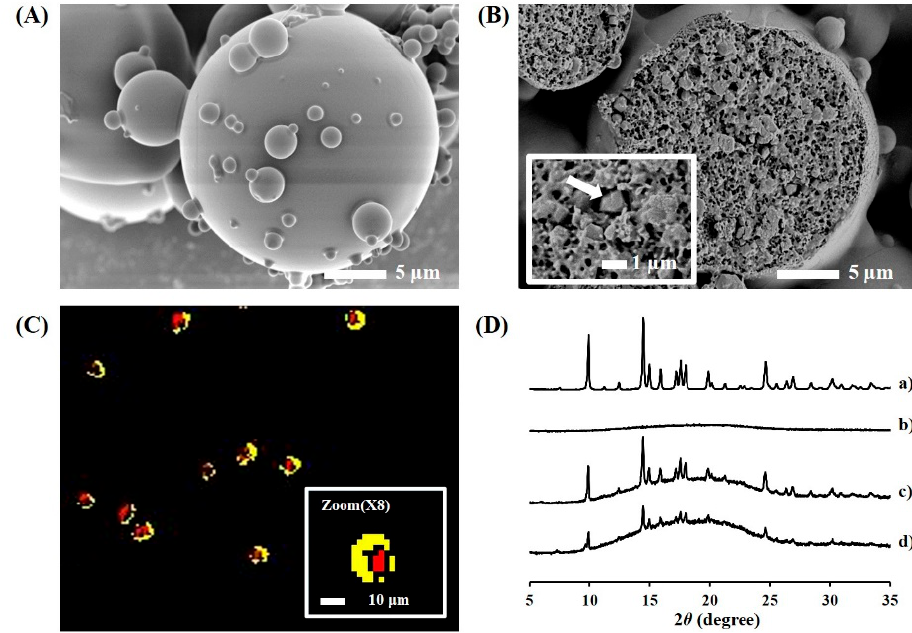
Figure 2. Morphological and physical characteristics of the microcrystals-loaded MSs. Representative micrograph of ( A ) intact and ( B ) cross-sectioned microcrystals-loaded MS (F4), ( C ) hyperspectral image of microcrystals-loaded MSs, and ( D ) XRD patterns of (a) TA microcrystals, (b) blank MS, (c) F4 MS (drug:polymer = 1:5), and (d) F8 MS (1:10); Notes: Inset in ( B ) is × 5000 magnified images and the arrow points to the TA crystal surrounded by the polymeric matrices. In the hyperspectral image ( C ), PLGA / PLA polymers and TA microcrystals are colored as yellow and red, respectively.